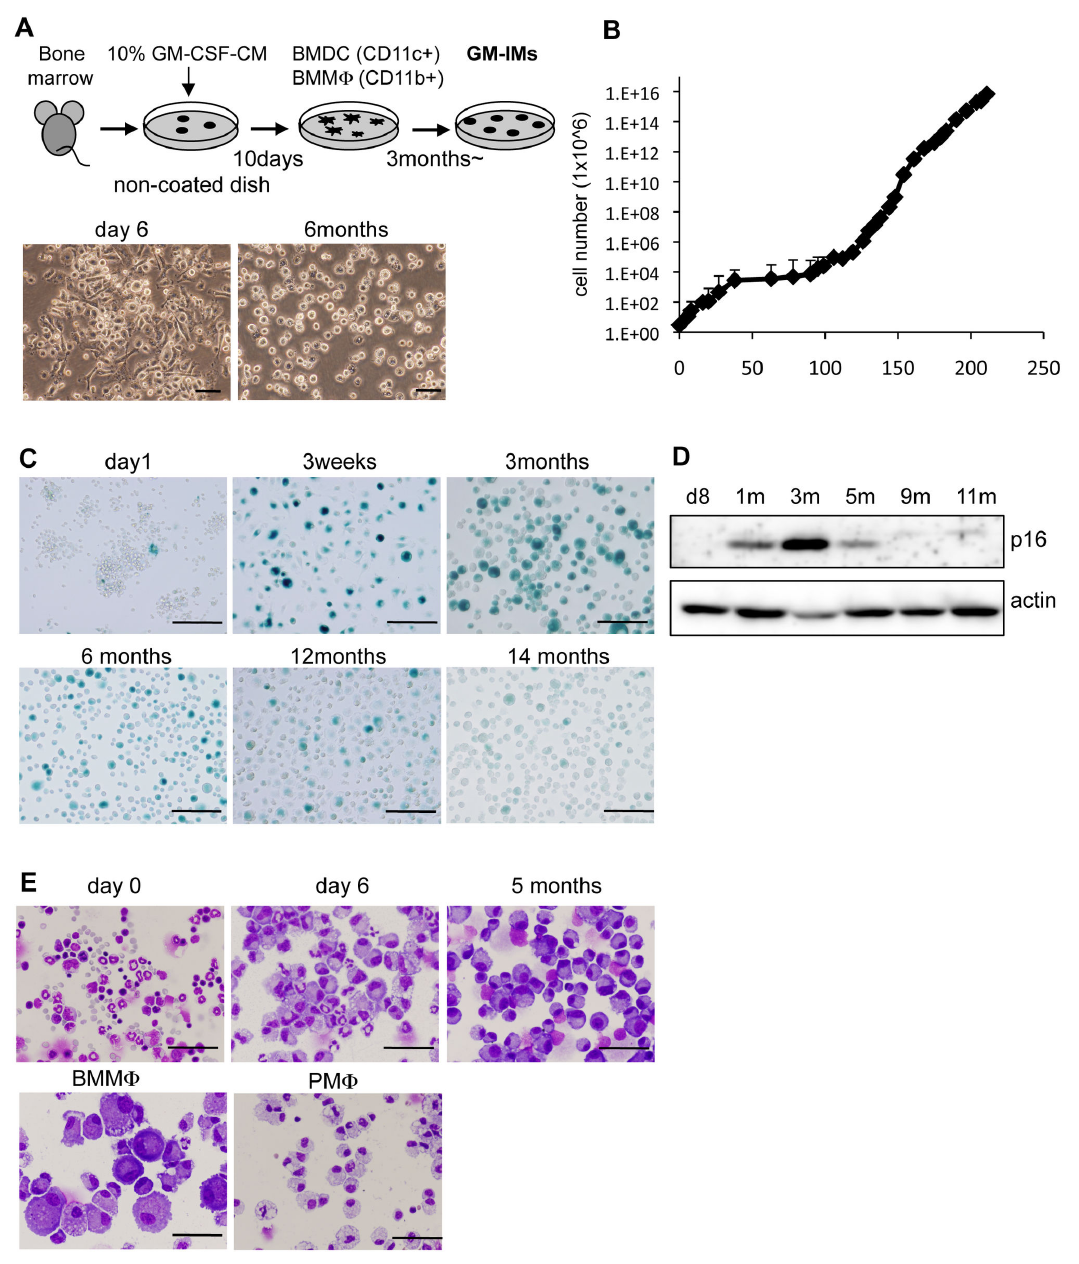
Figure 1. Establishment of GM-IMs from murine BM. (A) BM cells were taken from two-month old C57BL/6 or EGFP mice. Suspensions of BM cells (3x10 6 cells) were plated in ten cm diameter non-coated plastic culture dishes. They were cultured in RPMI-1640 supplemented with 10% GM-CSF-CM and 10% FBS. Lower panel shows phase contrast photograph of BM cultured with 10% GM-CSF-CM for six days or six months. Scale bars: 50 µm. (B) Growth curve of GM-IMs. BM cells cultured with 10% GM-CSF-CM for the indicated times, during which cells became GM-IMs. Data shown are the mean ratios ± SE of four independent experiments. (C) SA-β-gal staining of BM cells cultured with 10% GM-CSF-CM for the indicated times, during which cells became GM-IMs. Scale bars: 100 µm. (D) Expression of cellular senescent marker proteins. Cell lysates were Western blotted for p16. Β-actin was used as a control. (E) May-Grunwald-Giemsa staining of GM-IMs. Five months cultured GM-IMs was compared with days zero and six of BM culture in 10% GM-CSF-CM, BMMφ and peritoneal macrophages (PMφ). Scale bars: 50 µm. Data are representative of three independent experiments with similar results (A, C-E). doi: 10.1371/journal.pone.0076943.g001 PLOS ONE |